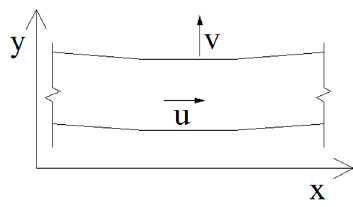
Figure 4. Two-dimensional fluid element.